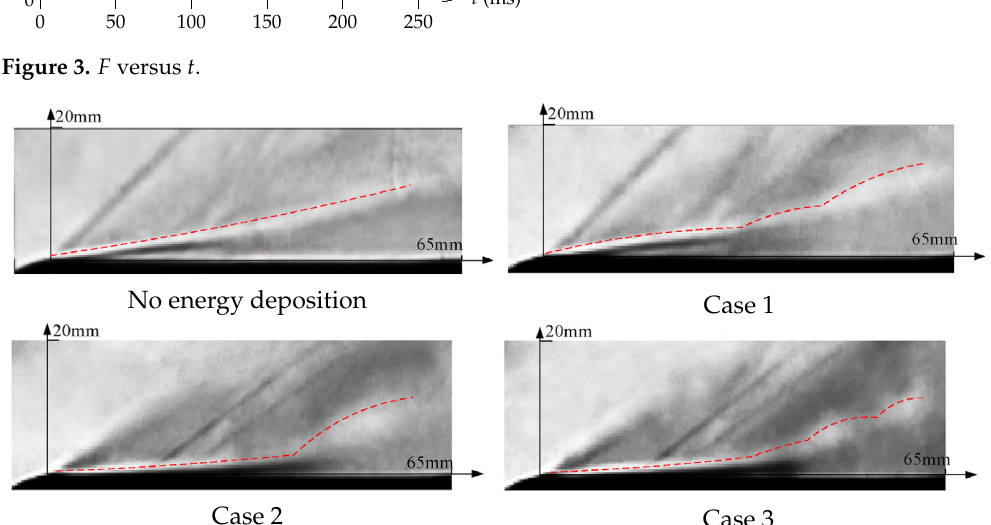
Figure 3. F versus t .